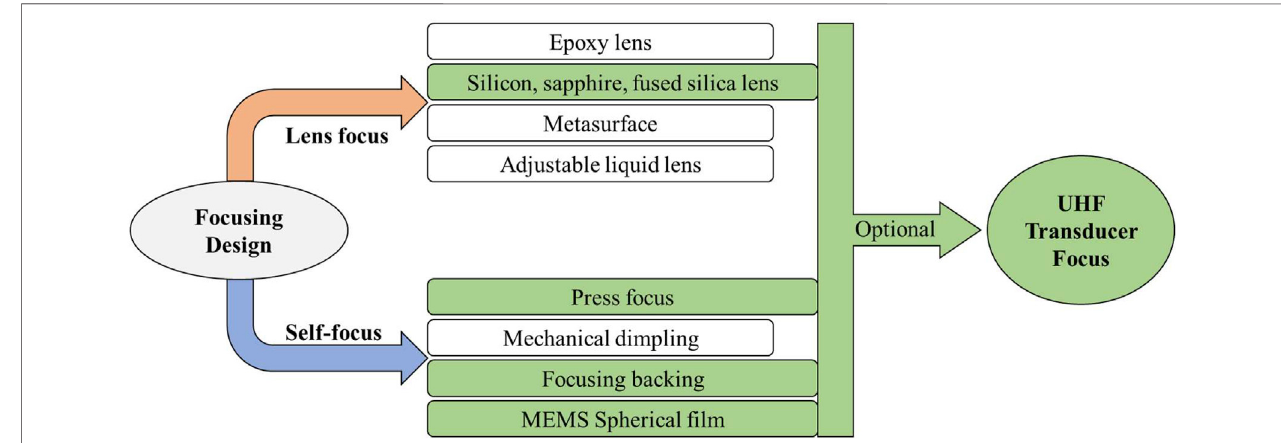
FIGURE 4 | Block diagram of Focusing